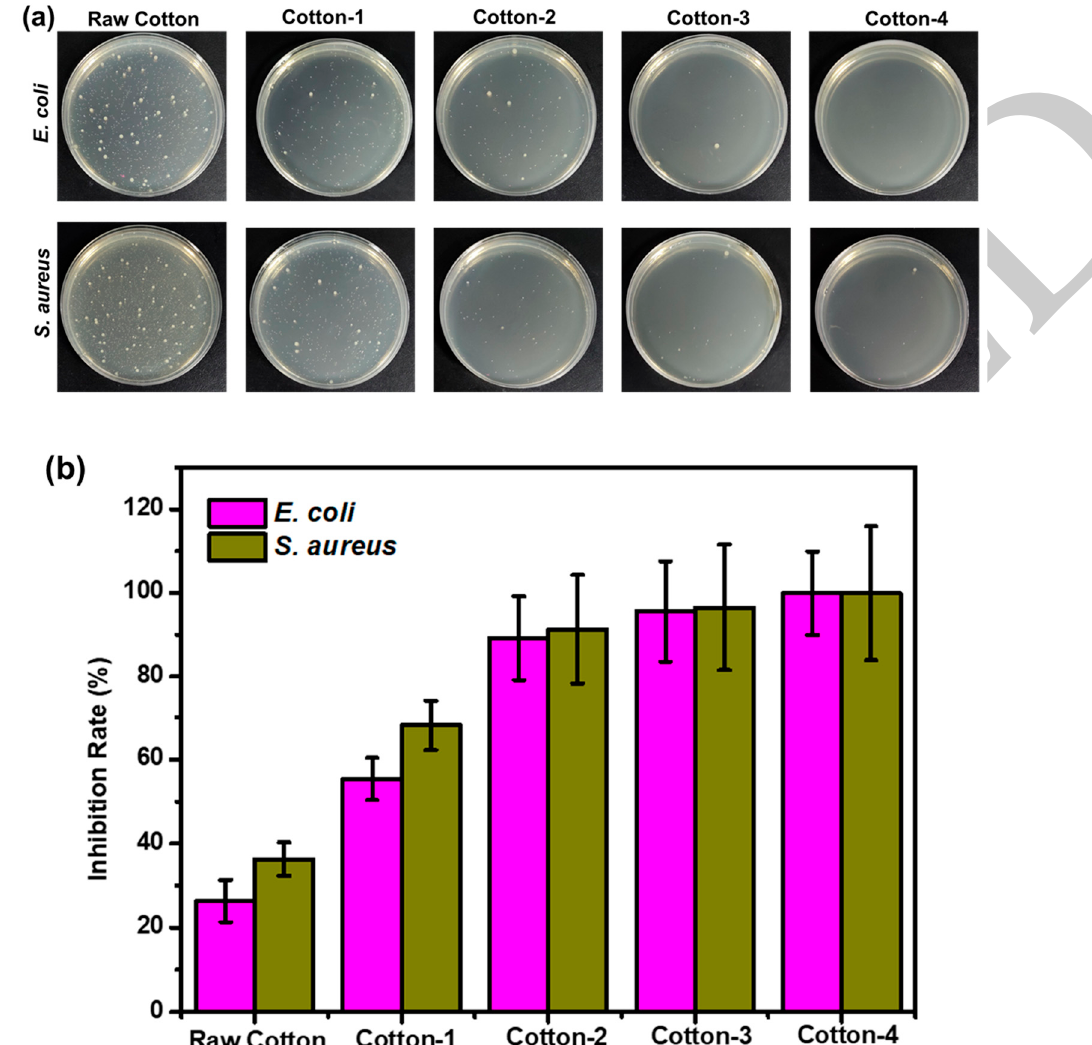
Figure 5. The antibacterial performance of cotton fabrics after being washed 50 times with anionic detergent in water. Cotton-1 fabric was treated with only dimethyl dodecyl [3-(trimethoxysilyl) propyl] ammonium chloride (CDDA); cotton-2, cotton-3 and cotton-4 fabric samples were the N-halamine containing antibacterial fabrics. ( a ) Photographs of the bacterial colony growing on an agar plate. ( b ) The inhibition rate of different cotton fabric samples.